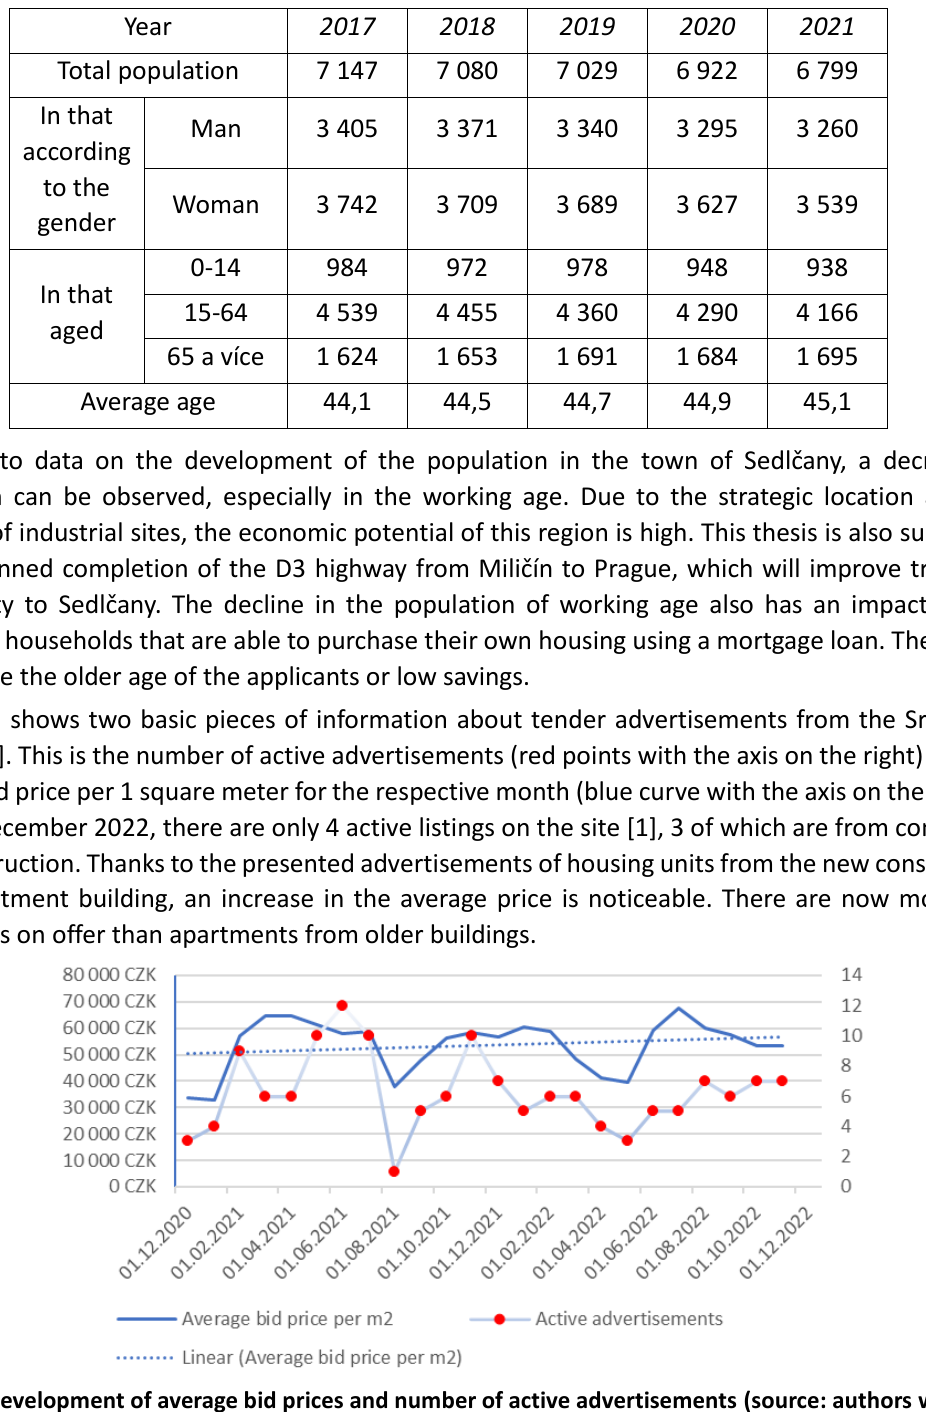
Table 2: Population status as of 31.12. (source: authors with use of [8])